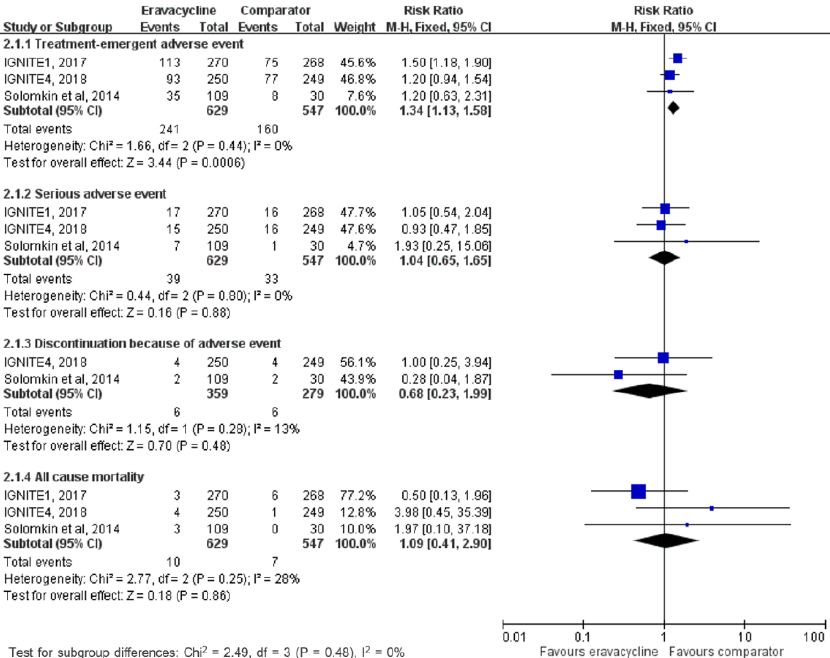
Figure 4. Adverse event risks with eravacycline and comparators in the treatment of complicated intra-abdominal infections.